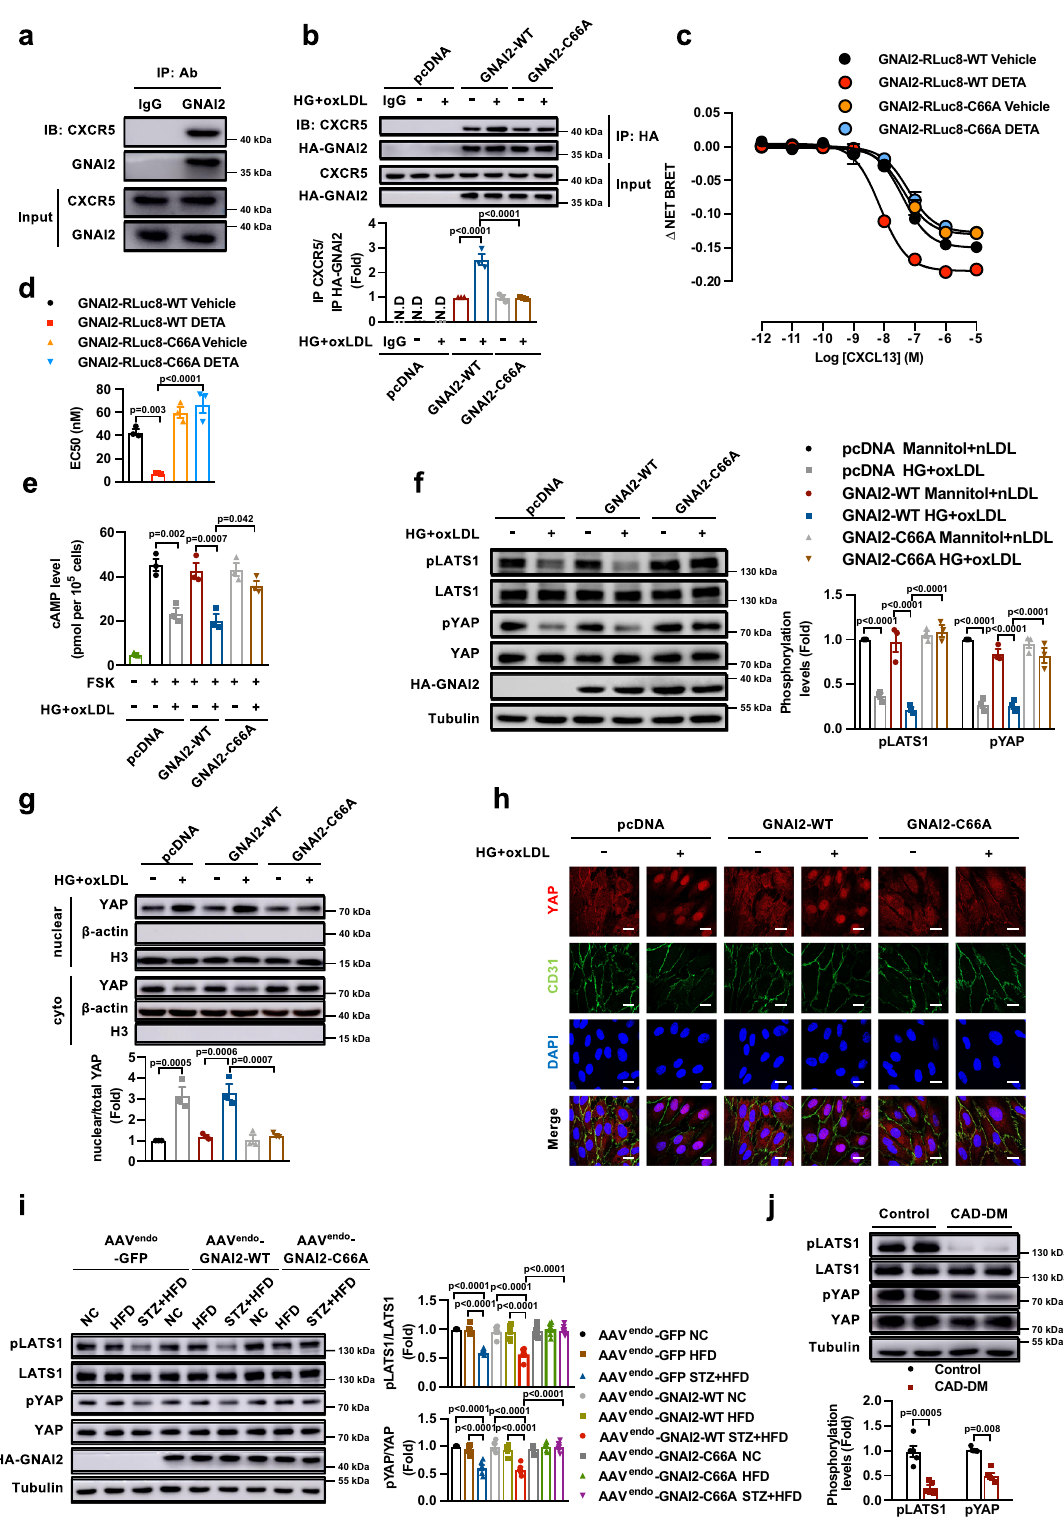
(PSR) staining of aortic roots revealed that melatonin reduced the necrotic core areas and increased fi brous cap thickness (Supple- mentary Fig. 7d, e). Besides, melatonin improved stability of atherosclerotic plaques, manifesting as increased collagen and smooth muscle cell content, decreased macrophage in fi ltration, and reduced lipid deposition (Fig. 7d, e). Melatonin also atte- nuated the intraplaque hemorrhage in aortic roots from STZ